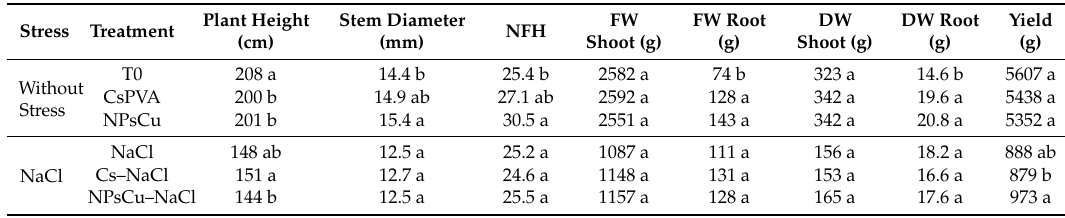
Table 1. Parameters of growth and development of tomato plants.